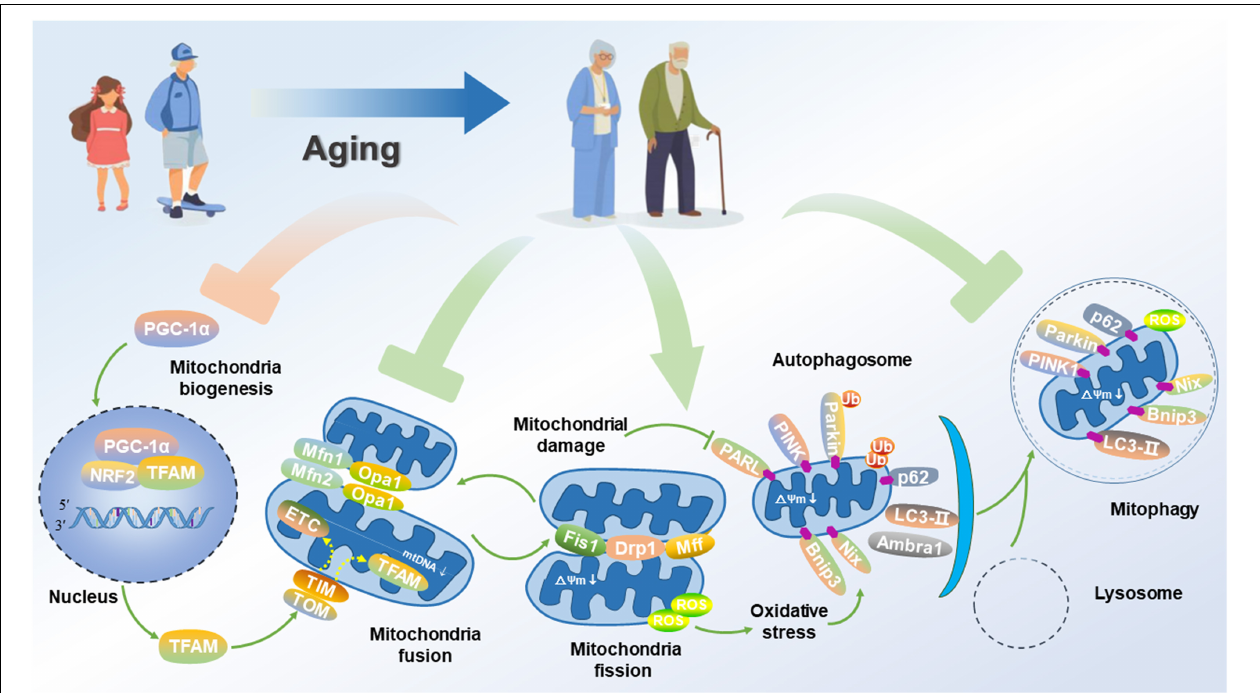
FIGURE 2 | Impairment of mitochondrial function and mitophagy in AD. Aged neuron displays attenuated PGC-1 α signaling for mitochondrial biogenesis, disrupted mitochondrial fusion and fission, and suppressed mitophagy flux, thus promoting a fragmented network of organelles. Consequently, these events activate PGC-1 α , thus allowing its translocation to the nucleus where it co-activates NRF2 to up-regulate the expression of TFAM. Aging causes some areas of the mitochondrial network to be dysfunctional. Mitochondrial fusion proteins such as Mfn1/2 and Opa1 for promoting the fusion of inner and outer membranes are down-regulated. Alternatively, damaged organelles undergo fission, mediated by the interaction of proteins such as Fis1, Drp1, and Mfn1/2 to constrict and remove the organelles, thus allowing for their clearance via mitophagy. Once separated, damaged mitochondria with a low (cid:49)(cid:57) m accumulation of PINK1 on their outer membrane. PINK1 recruits the Parkin, which subsequently ubiquitinates outer membrane proteins to flag the organelle for removal via mitophagy. The adapter p62 binds to the ubiquitin on the tagged cargo and LC3-II embedded in the phagophore membrane for promoting the formation of the autophagosome, thereby fusing with the lysosome to degrade the damaged or dysfunctional